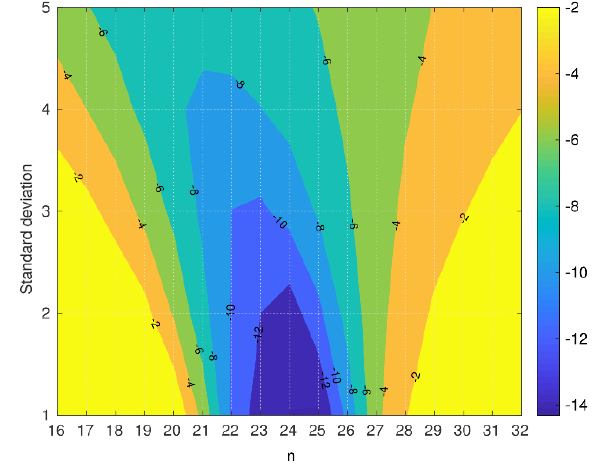
Figure 6. D pg,nuc difference between the nucleation-mode peak di- ameter (nm) when using B-c vapour pressure and the nucleation- mode peak diameter when using A-a vapour pressure for modal compositions C n H ( 2 n + 2 ) , where n = [ 16 : 32 ] .